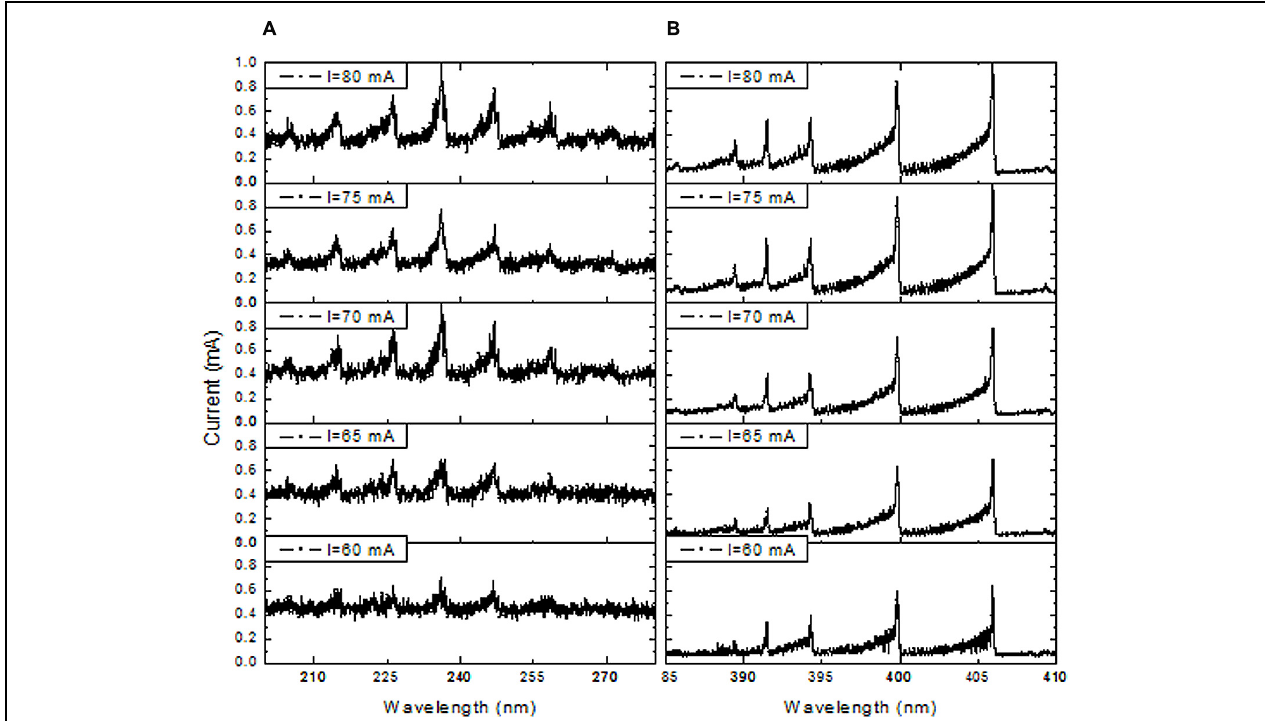
FIGURE 4 | Effect of DBD current increment on emission spectra of NO bands in the range of 200 to 280 nm (A) and in the N 2 first negative system (391 nm ) spectra in the range of 385 to 410 nm (B).